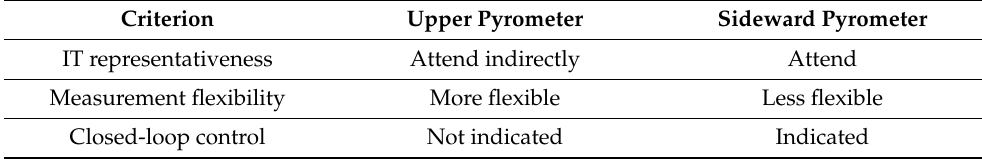
Table 2. Summary of limitations and functionalities of the two measurement strategies. Criterion Upper Pyrometer Sideward Pyrometer IT representativeness Attend indirectly Attend Measurement flexibility More flexible Less flexible Closed-loop control Not indicated